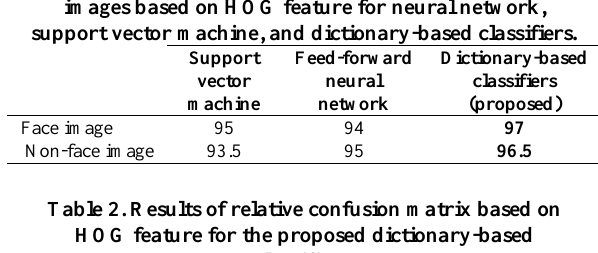
Table 2. Results of relative confusion matrix based on HOG feature for the proposed dictionary-based classifiers.